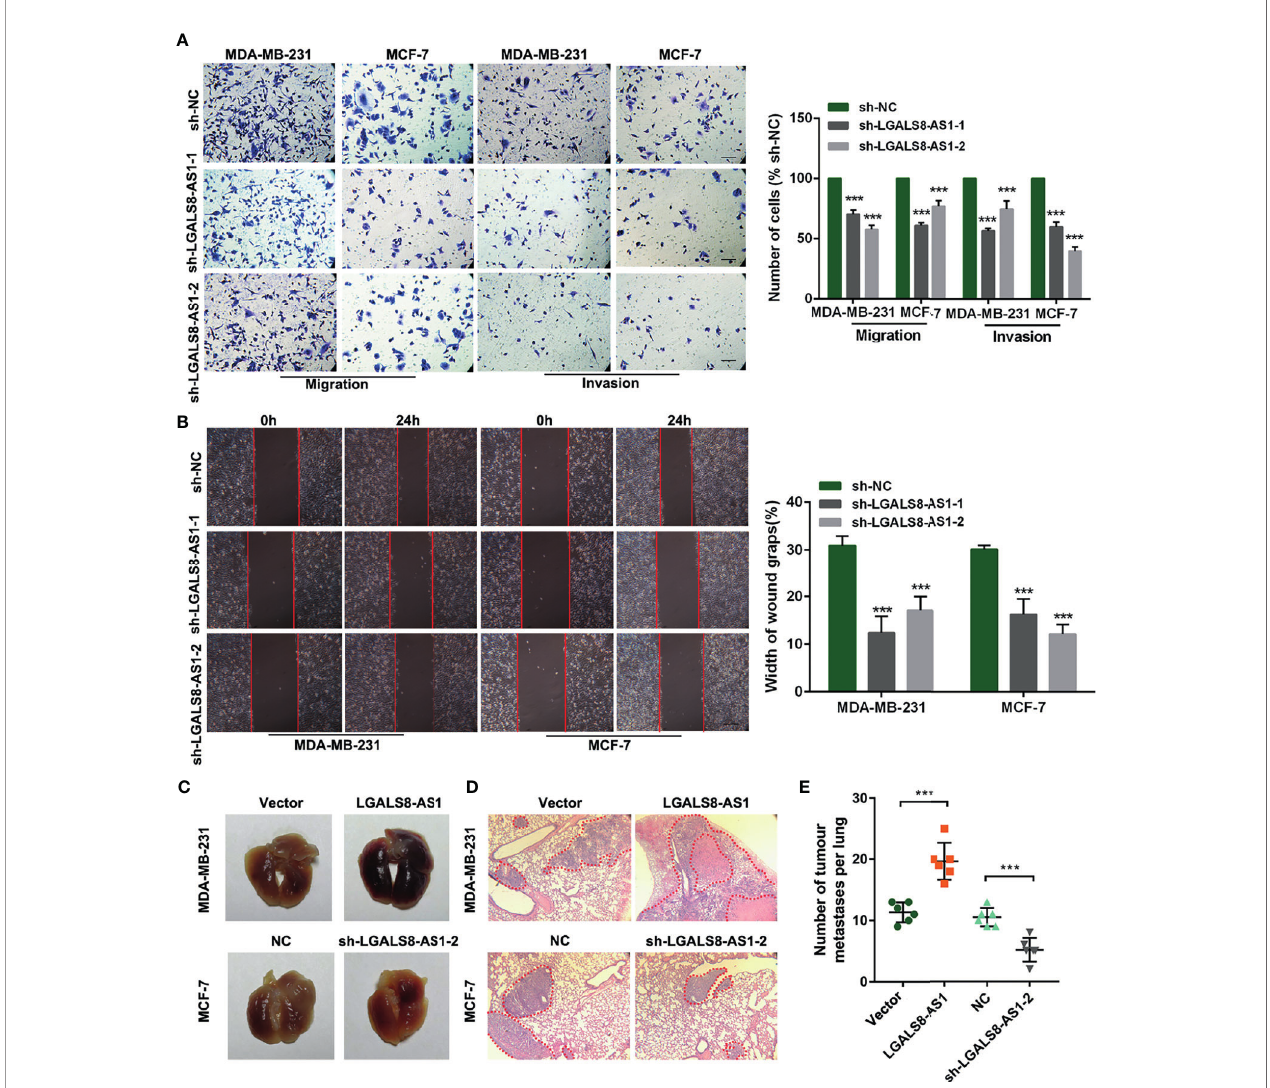
FIGURE 2 | LGALS8-AS1 promotes the invasion and metastasis of breast cancer cells. (A, B) Invasive and metastatic capacities detected in MDA-MB-231 and MCF-7 cells with LGALS8-AS1 knockdown using Transwell and scratch wound assays. (C, D) Representative images of macroscopic metastatic nodules in the lung and hematoxylin – eosin (HE) staining results of a mouse lung metastasis model constructed with MDA-MB-231 and MCF-7 cells with LGALS8-AS1 stable overexpression or knockdown. (E) Number of tumor metastatic nodules counted in the mouse lung metastasis model. *** p <